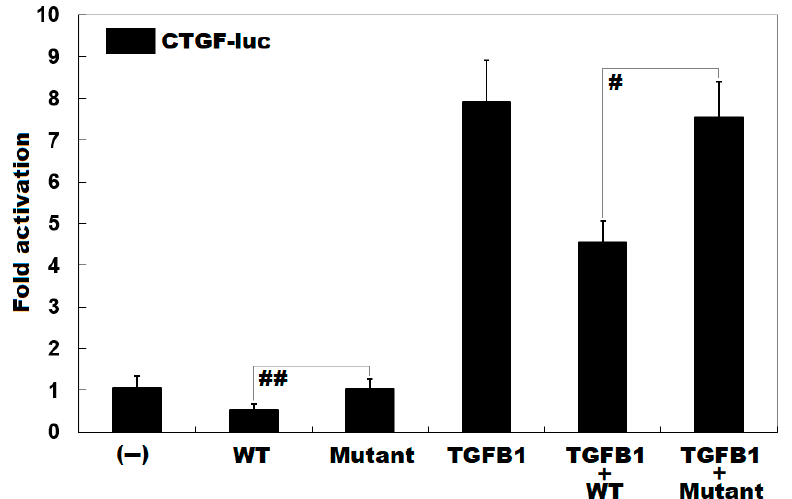
Figure 3. Diminished inhibitory effect of KLF15 on CTGF resulting from the mutation. In cultivated NIH 3T3 cells, activation of the CTGF promoter-driven luciferase by wild-type (WT) or Lys229*- mutant KLF15 (Mutant), in the absence or presence of TGFB1, showed that the inhibitory effect of the mutant on CTGF was significantly decreased. Experiments were carried out in triplicate, and the data were given as mean values ± SD. ## and # indicate p < 0.05 and p < 0.01, respectively, in comparison with their wild-type counterparts.